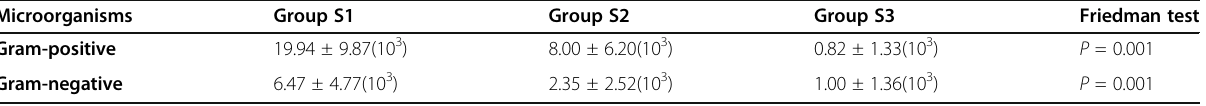
Table 5 Comparison of the mean colony-forming units of Gram-positive and Gram-negative microorganisms among the three